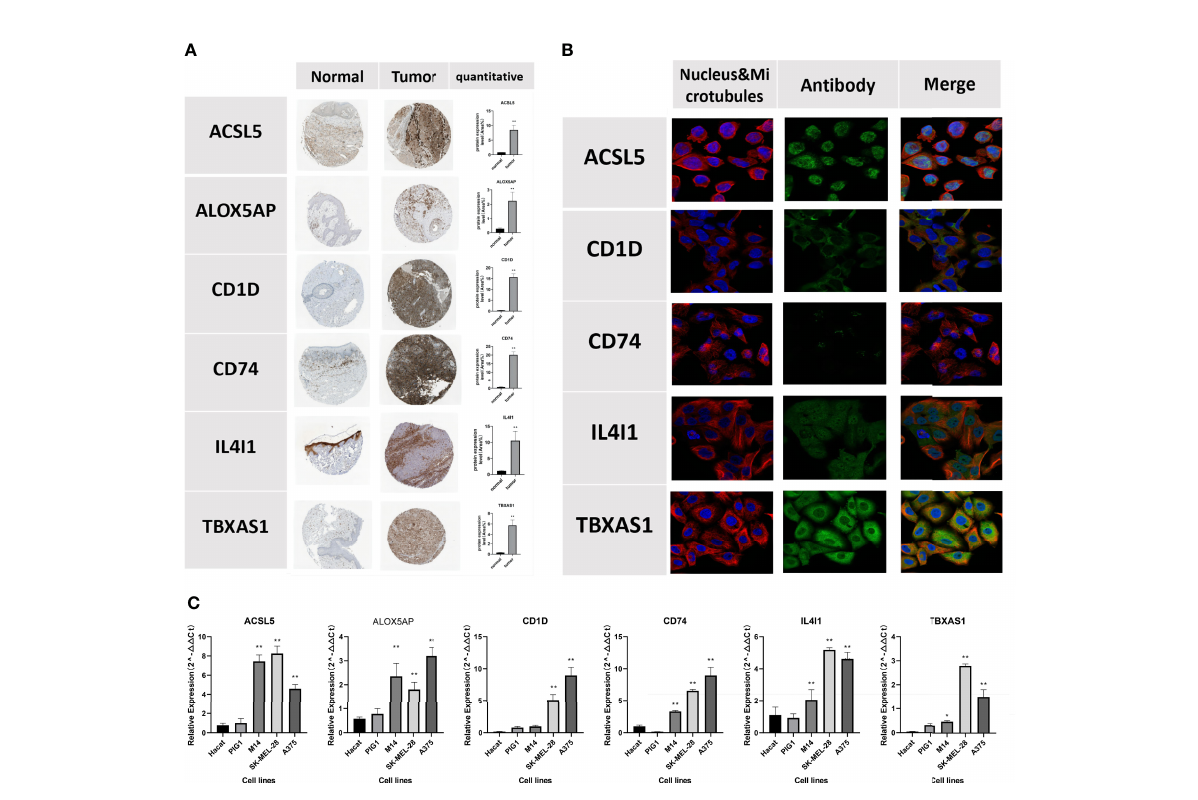
FIGURE 12 Veri fi cation of the protein expression of the 6 FAMGs using the HPA database. (A) Immunohistochemical images show the protein expression of ACSL5, ALOX5AP, CD1D, CD74, IL4I1, and TBXAS1 in CM and skin tissue. (B) Immuno fl uorescence show that ACSL5, CD1D, CD74, IL4I1 , and TBXAS1 are mainly located in the cytosol and nucleoplasm. (C) qRT-PCR, showing the relative expression of ACSL5, CD1D, CD74, IL4I1 and TBXAS1 were signi fi cant differences between 2 normal human cell lines and 3 melanoma cell lines. *P ≥ 0.05; **P ≥